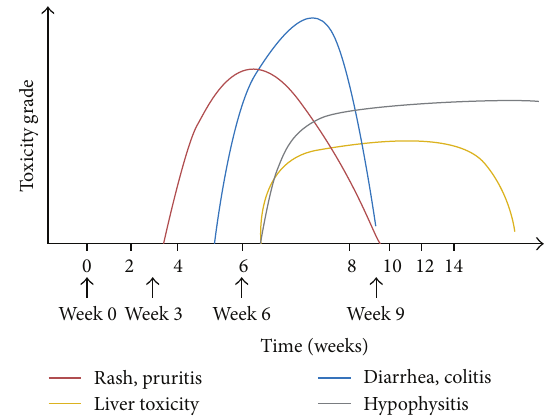
Figure 2: Kinetics of appearance of irAEs according to organ system involved [11]; adapted with permission from Weber et al. 2012 [11].